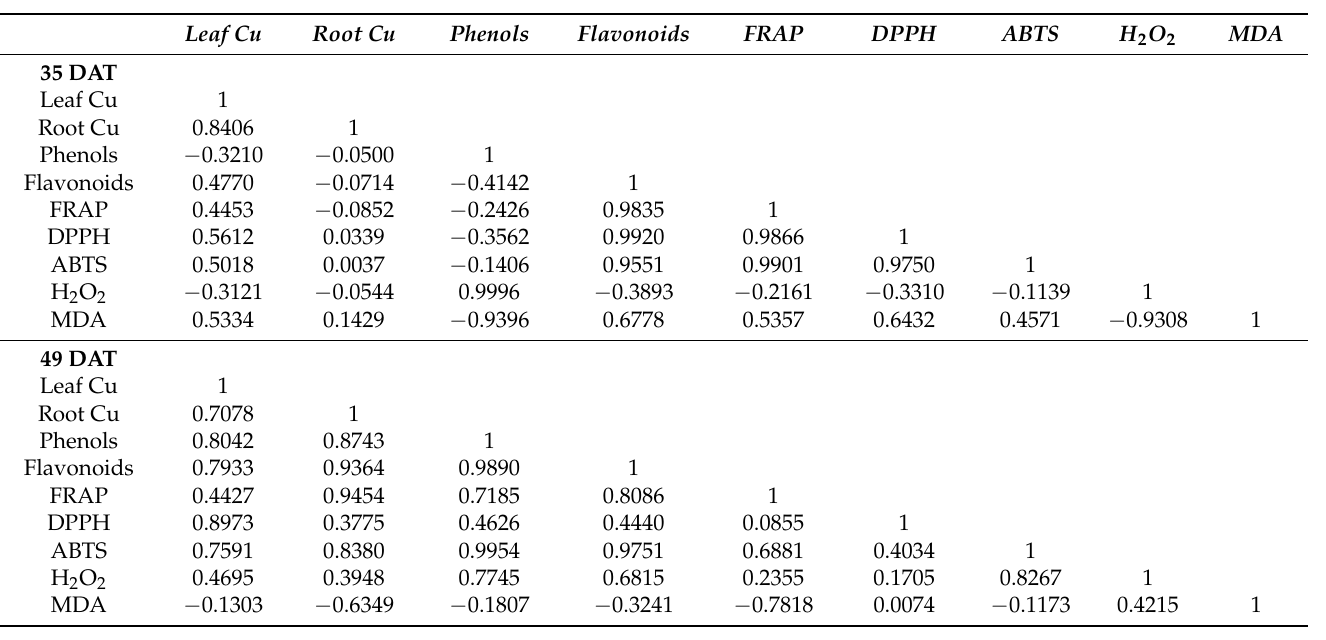
Table 5. Pearson’s correlation table for leaf and root content of copper (Cu), leaf content of total phenols, flavonoids, H 2 O 2 and malondialdehyde (MDA), and leaf antioxidant capacity determined using FRAP, DPPH or ABTS assays, in pelargonium plants grown hydroponically in perlite and exposed to four different Cu concentrations (4–25–50–100 µ M Cu 2+ ) in the nutrient solution, sampled at 35 and 49 days after transplanting